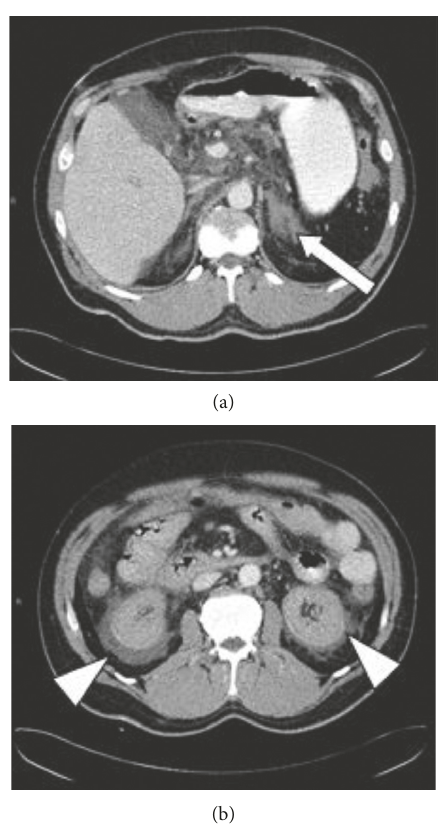
Figure 1: Contrast-enhanced abdominal CT demonstrates hae- morrhage of the swollen adrenal glands (arrow) and status after splenectomy (a). There is fluid collection in the perirenal space (arrowheads), and the corticomedullary differentiation of the kidneys is lost